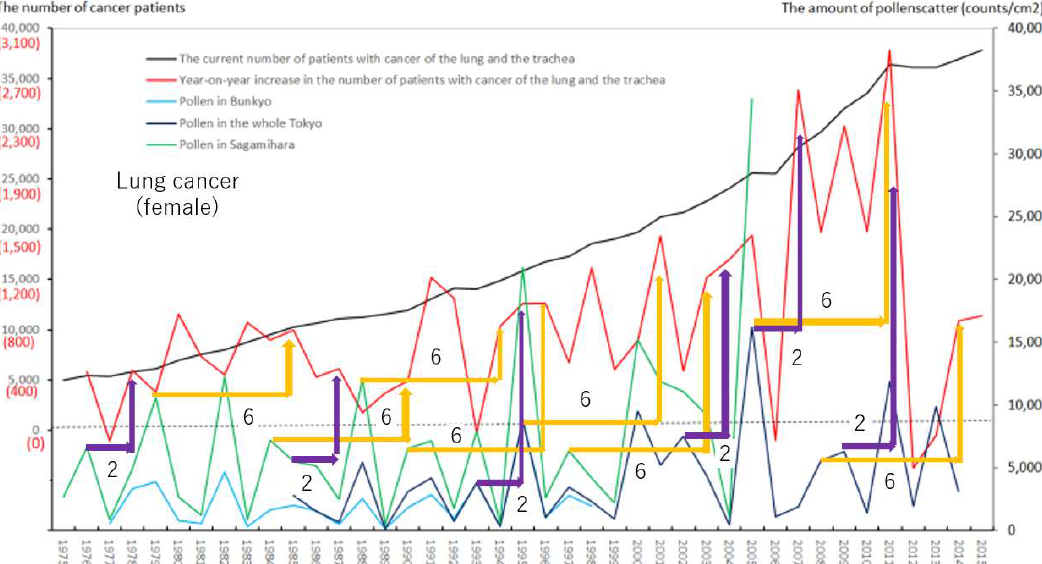
Figure 4. The current number of Japanese females (presently registered patients) registered for cancer of the lung and the trachea at the year diagnosed, its year-on-year increase (newly registered patients), and the amount of air borne pollen scatter in 3 areas during the period from 1975 to 2015. The line graphs for females with cancer of the lung and the trachea representing numbers of presently and newly registered patients in each year, as well as the amount of pollen scattered during the period from 1975 to 2015. Violet or orange arrows indicate phasic increments of newly registered patients occurring two or six years after phasic increments of airborne pollen scatter,